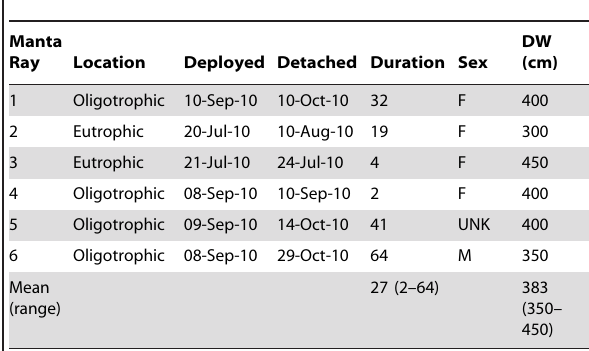
Table 1. Deployment metrics for six manta